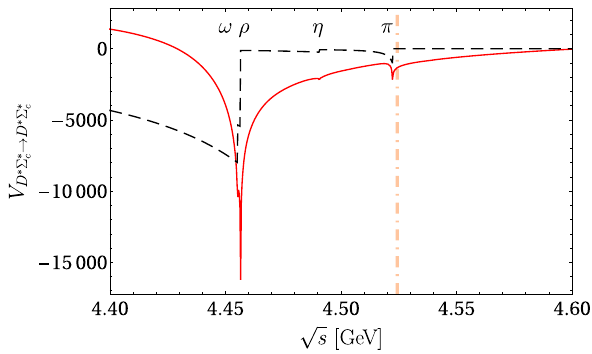
Fig. 1 S -wavepotentialfor D ∗ (cid:2) ∗ c → D ∗ (cid:2) ∗ c with ( I , J ) = ( 1 / 2 , 5 / 2 ) (realpart:solidcurve,imaginarypart:dashedcurve).Thecorresponding threshold is represented by the orange dash-dotted line. The left-hand cuts from left to right are generated by the ω , ρ , η and π exchange, respectively